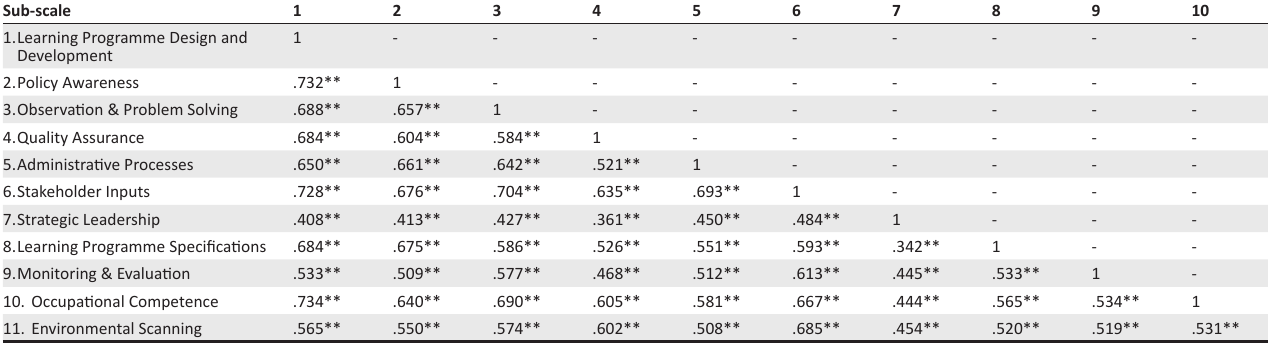
TABLE 6: Correlations amongst the sub-scales of the learning programme management and evaluation scale.